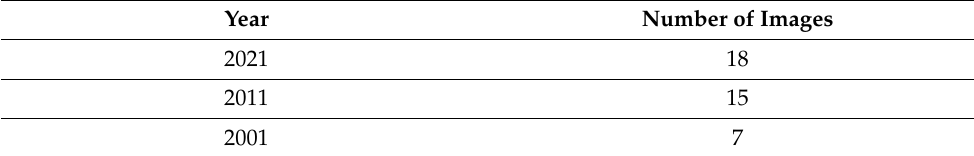
Table 2. Total number of images imported in Google Earth Engine for